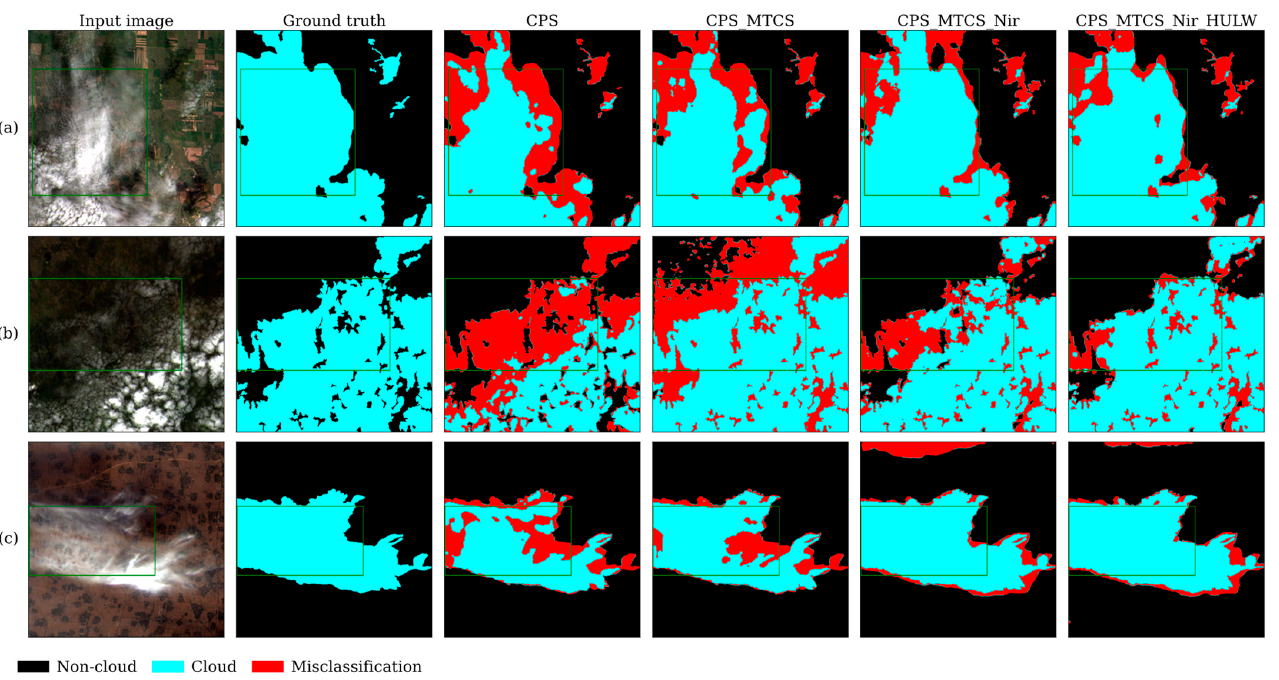
Figure 4. Visualizations of ablation experiments on the SPARCS dataset at a labeled ratio of 1/8. ( a ) thick clouds, ( b ) large scale range of broken clouds of varying sizes, ( c ) thin clouds.